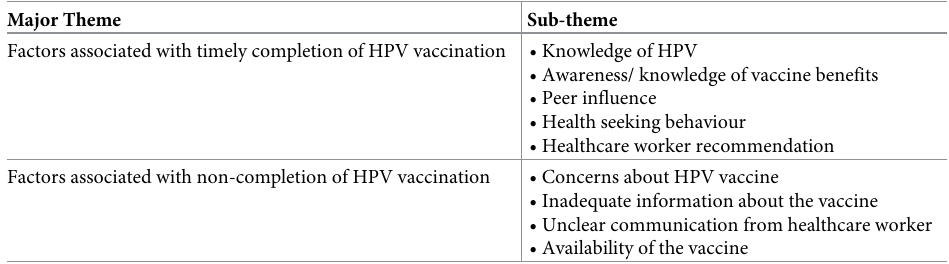
Table 5. Key themes factors influencing timely completion of HPV vaccination among girls 9–14 years attending the adolescent clinic Mulago